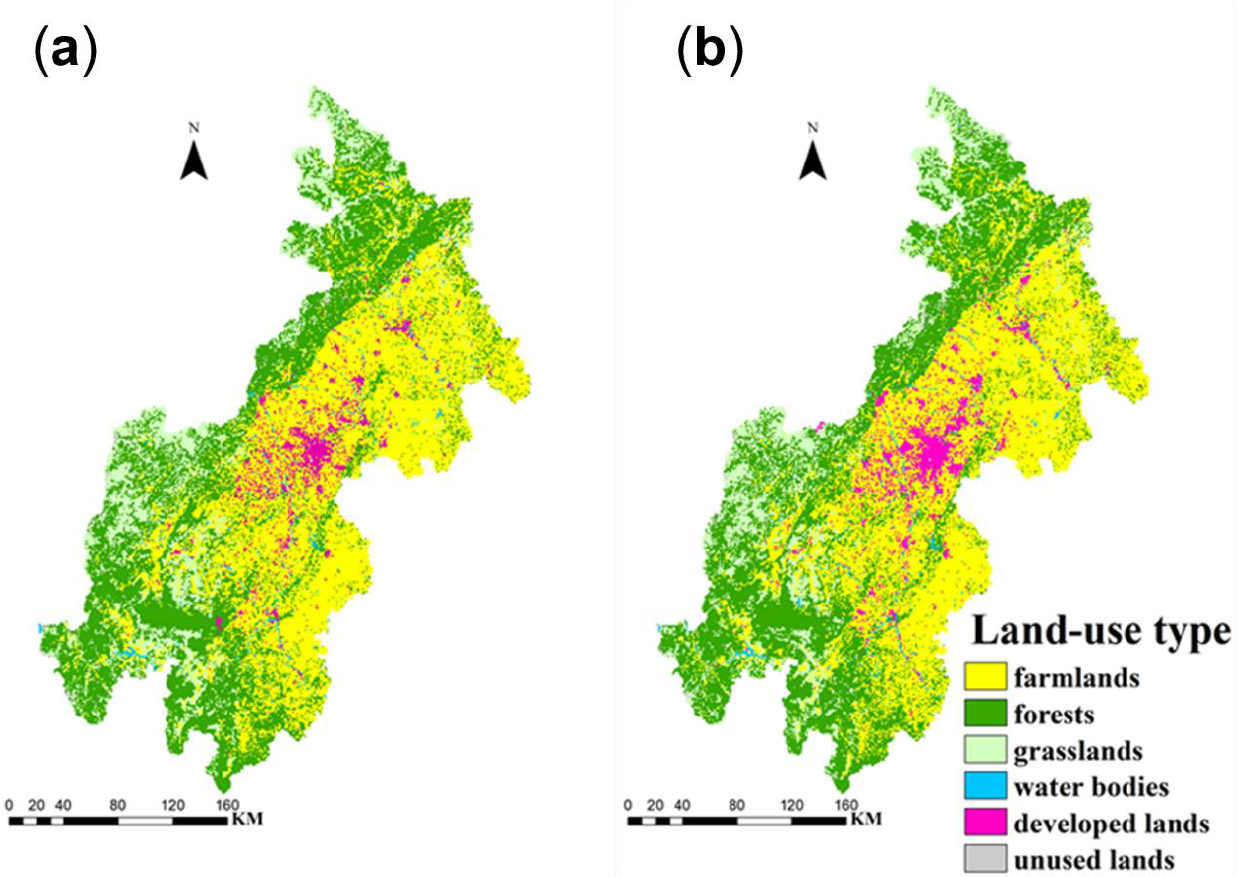
Figure 2. Land-use types in the Chengdu Plain urban agglomeration ( a ). 2015; ( b ). 2018. Considering that data collected at an AAQ monitoring point generally can reflect the AAQ in the area within a radius of 0.5–4 km, data were sampled in this study for the study area at multiple scales, i.e., multiple grid cell sizes, starting from 10 km × 10 km and then increasing by a factor of 2 to 20 km × 20 km and further to 40 km × 40 km. A total of 732, 185, and 47 grid cells with different side lengths and the corresponding centers were obtained using ArcGIS 10.0. The LP metrics were calculated for each grid cell at each scale, and the obtained values were assigned to the center of each grid cell using the “Extract Values to Points” tool. Similarly, the spatial distribution of the concentration of each of the four pollutants was segmented at the same scales to determine the concentrations of each pollutant at multiple scales (Figure 3). The correlations between each LP metric and the concentrations of the pollutants at each scale were analyzed using SPSS software to examine the multiscale coupling relationships between the landscape types and structures and the concentrations of the